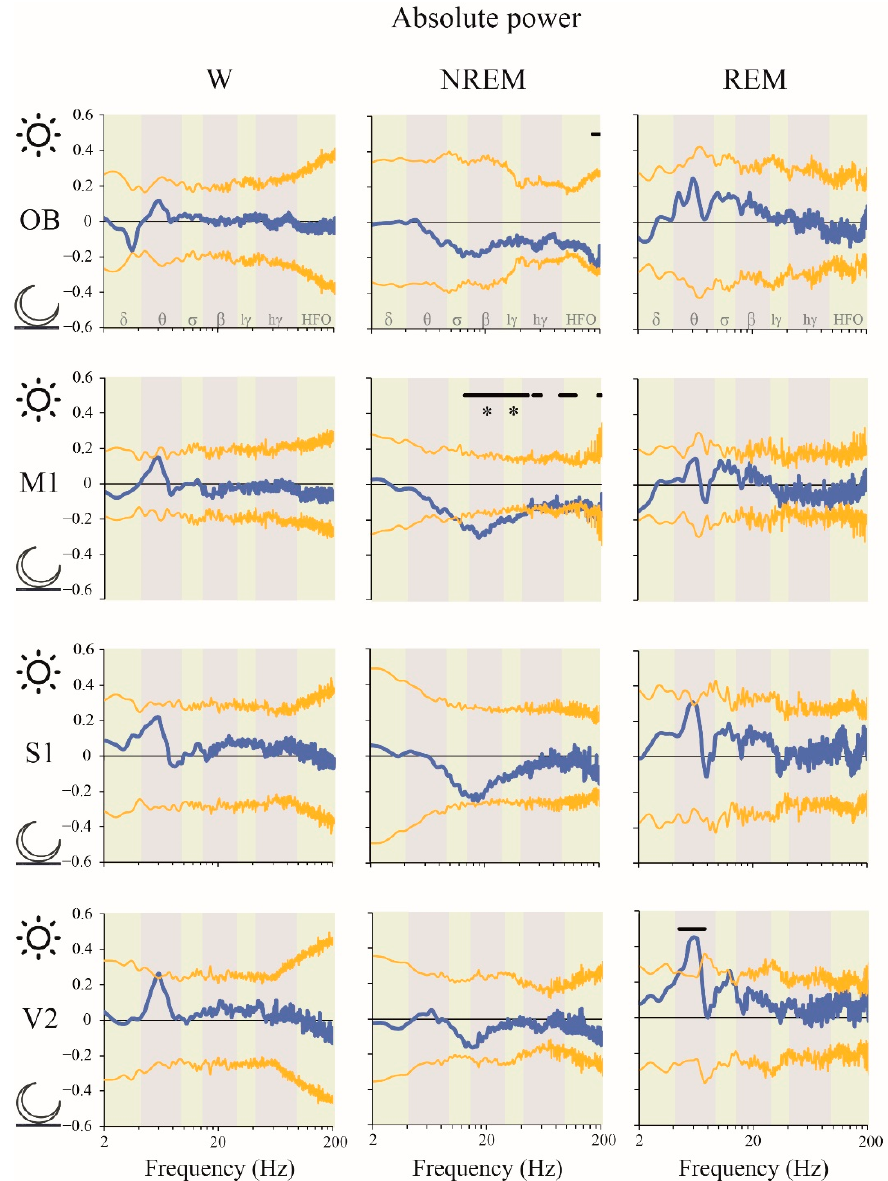
Figure 5. Absolute power: light vs. dark phase di ff erences. The blue traces indicate the mean power di ff erence between light and dark phases. The yellow lines represent the standard deviation of the mean with respect to zero. The statistical evaluation was performed by the two-tailed paired t -test with Bonferroni correction for multiple comparisons; * indicates significant di ff erences, p < 0.0071 ( n = 11). We also performed a data-driven approach comparing empirical clusters of frequencies; black lines represent statistical di ff erences in cluster of frequencies, p < 0.05. In M1 the following frequency clusters were significantly larger during NREM sleep in the dark phase: 13 to 46 Hz ( p = 0.001), 51 to 60.5 Hz ( p = 0.016), 87 to 92 Hz ( p = 0.038), 93.5 to 100 Hz ( p = 0.025), 101 to 111 Hz ( p = 0.012), 112.5 to 119.5 Hz ( p = 0.024), 124 to 125.5 Hz ( p = 0.047), 186.5 to 192 Hz ( p = 0.036) and 193 to 200 Hz ( p = 0.029). In the OB during NREM sleep, the power of the frequencies 171.5 to 187.5 and 188.5 to 199.5 Hz were larger during the night ( p = 0.018 and p = 0.047, respectively). During REM sleep, the cluster 4.5 to 7.5 Hz was higher during the day than during the night in V2 ( p = 0.038). The analysis was performed for the right hemisphere. OB, olfactory bulb; M1, primary motor cortex; S1, primary somato-sensory cortex; V2, secondary visual cortex; l γ , low gamma or LG; h γ , high gamma or HG; HFO, high frequency oscillations.